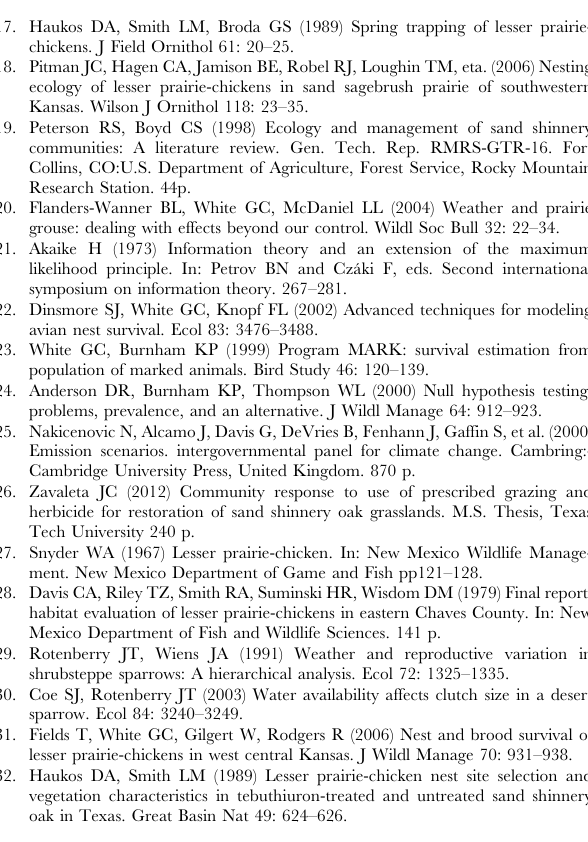
Figure S1 Linear relationship between clutch size and winter precipitation. Figure S2 Linear relationship between clutch size and winter temperature. Figure S3 Linear relationship between incubation start date and winter precipitation. Figure S4 Linear relationship between incubation start date and winter temperature. Figure S5 Linear relationship between nest survival and winter precipitation. Figure S6 Linear relationship between nest survival and winter temperature. Figure S7 Interannual differences in nesting cover . Differences in nesting cover between a cool, wet spring (2010; top) and hot, dry spring (2011; bottom) on the study area in